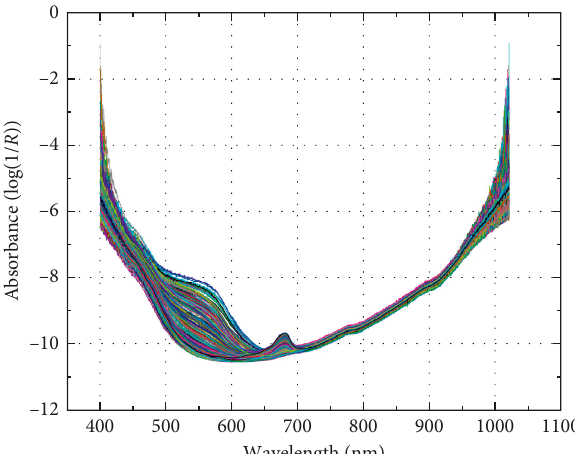
Figure 3: NIR spectra of all measured apples between 400 and